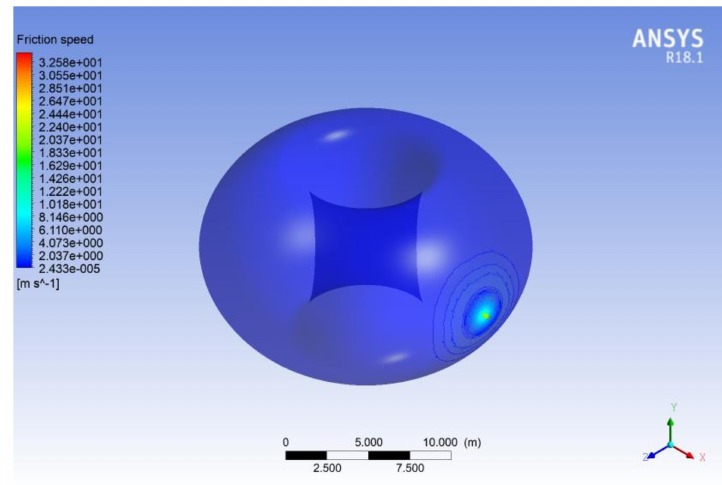
Figure 5. Friction velocity over the tokamak surface at 1 × 10 − 2 s.